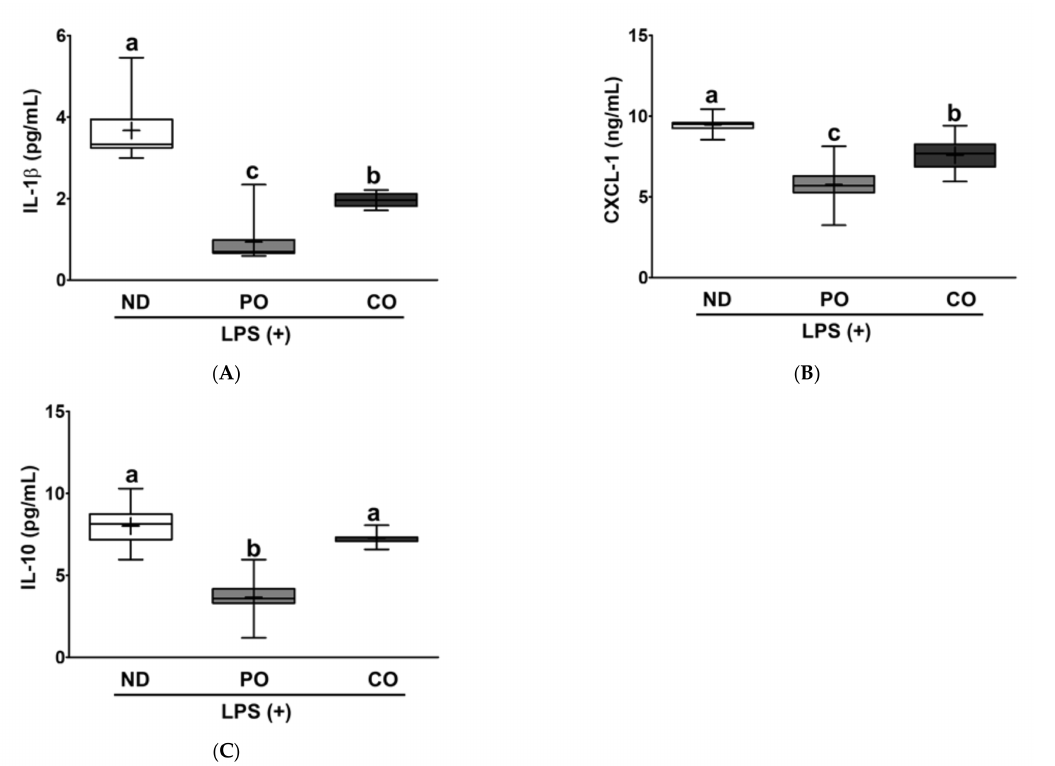
Figure 8. Partial replacement of dietary fat with PO or CO and LPS challenge on lipid contents and histology analysis in EAT. Mice were fed either an ND or an ND partially replaced with PO or CO for 12 weeks and then treated with LPS (1 mg/kg) for 24 h ( n = 8 per group). ( A ) Triglyceride (TG) levels in EAT; ( B ) total cholesterol (TC) levels in EAT. ( C ) H&E staining of adipose tissue (bar = 50 µ m, 20 × magnification); ( D ) adipocyte area (mm 2 ). Values are presented as box and whisker plots representing 8 mice per group. Data were analyzed using one-way ANOVA followed by Tukey’s post hoc test. Labeled means without a common letter differ ( p < 0.05).